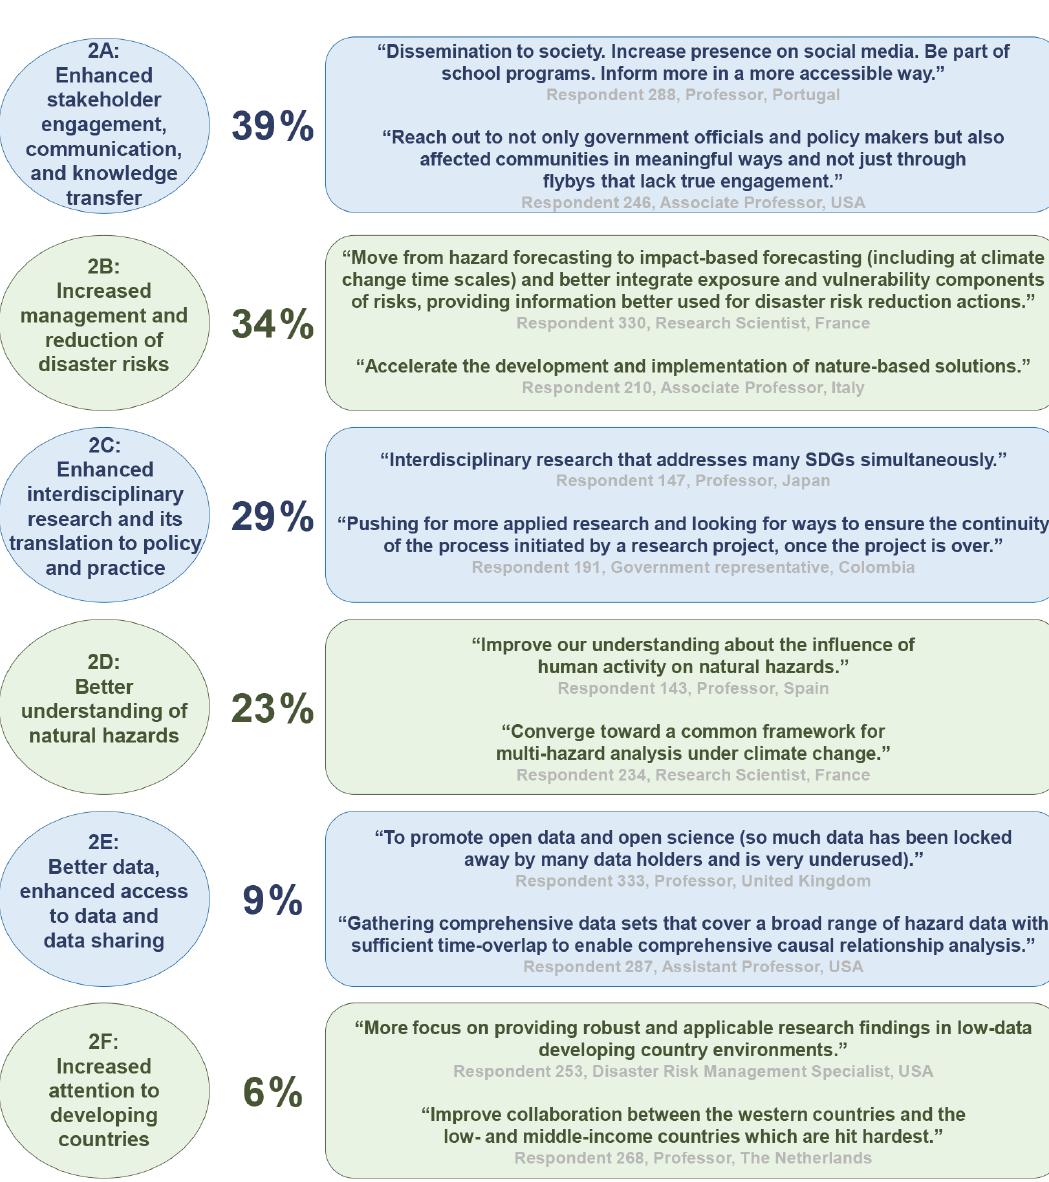
Figure 4. Six themes identified through thematic analysis of responses of 350 natural hazard community members to the NHESS survey question Q2 “what three broad step changes should or could be done by the natural hazard community to address natural hazards in achieving the Sustainable Development Goals” along with example quotes. Percentages indicate the percentage of all respondents ( n = 350) whose answers were classified under a given